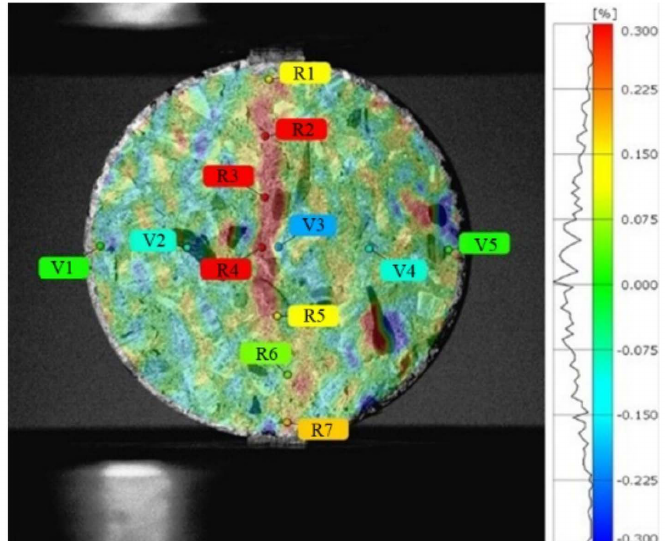
Figure 6. Characteristic points.